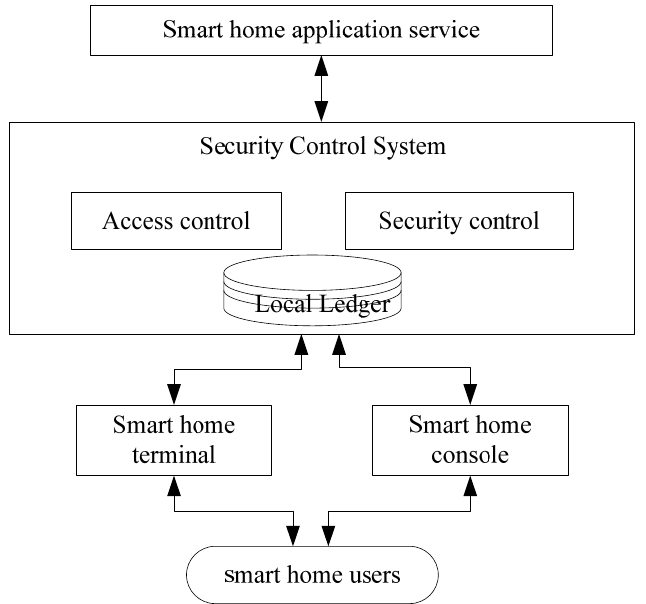
Figure 6. The architecture of security control system.